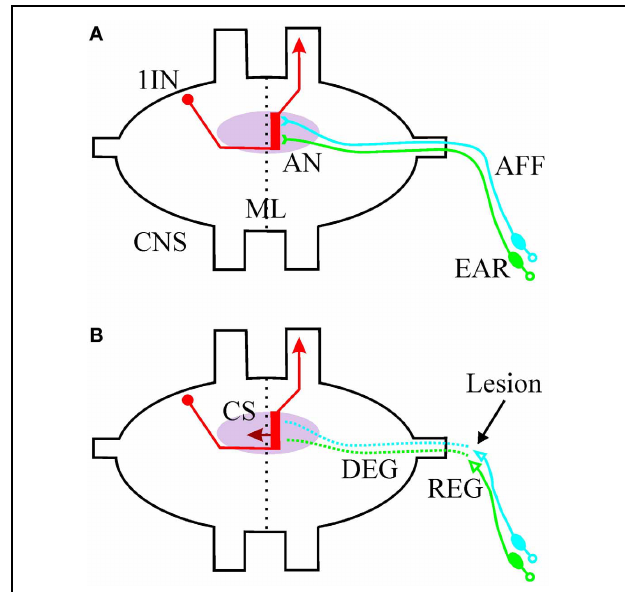
FIGURE 1 | Schematic drawing of the afferent auditory system of Orthoptera (exemplified for Ensifera). (A) The primary sensory neurons are located in the peripheral ear and project their axons (AFF, afferents) to an auditory neuropile (AN, pink) in the central nervous system (CNS). The afferents synapse onto the dendritic region (red bar) of first order auditory interneurons (1IN). The processing is strictly ipsilateral of the midline (ML). The interneurons could transport the information to the contralateral side (not shown) and/or toward higher centers in the CNS. (B) After a peripheral lesion of the afferents (arrow), the distal part of the axon degenerates (DEG) and regeneration starts at the proximal part (REG). First order interneurons grow collateral sprouts (CS) across the midline into the intact part of the auditory neuropile.